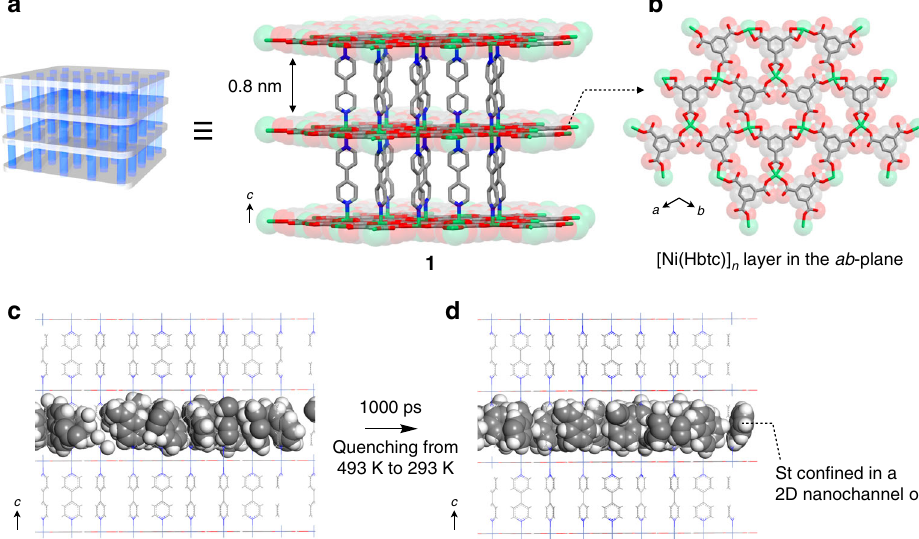
Fig. 2 MOF structures. a Crystal structure of 1 . b The structure of the [Ni(Hbtc)] n layer. Atoms: Ni (green), O (red), C (grey), and N (blue). H atoms are omitted for clarity. Disordered bipyridine moieties have been omitted for clarity in a . An MD simulation snapshot of 1 ⊃ St c before and d after quenching the dynamics from 493 to 293 K over 1000 ps under NVT condition, where the St monomer units are con fi ned within a single interstice of 1 . The MD simulations reveal that the St monomers do not leap across [Ni(Hbtc)] n layers into neighbouring interstices (Supplementary Fig.